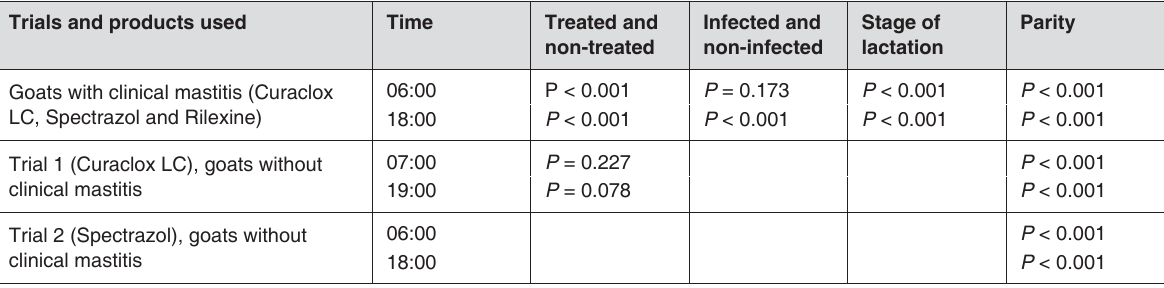
TABLE 3 Goats with clinical mastitis: Differences in log SCC of treatment and control groups, infected and non-infected udder halves, stages of lactation and parity for both treatment times Trials and products used